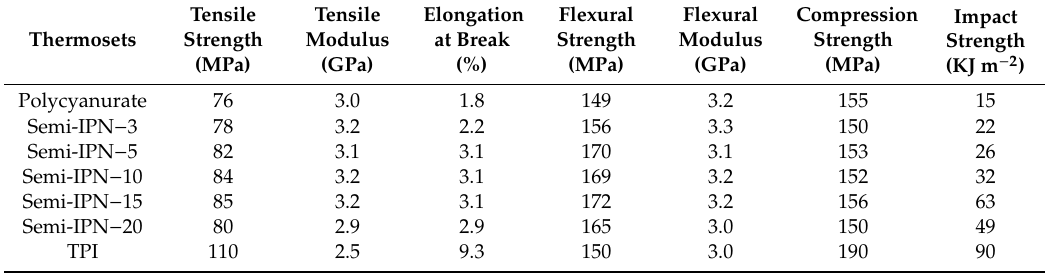
Table 3. Mechanical properties of polycyanurate, TPI, and